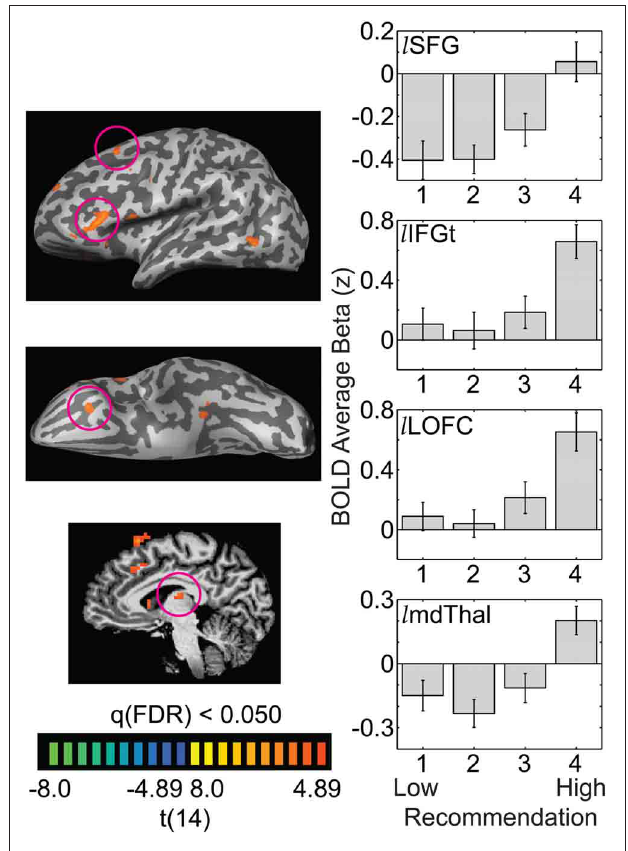
FIGURE 5 | Anterior frontal regions and an associated region of the thalamus show non-linear, “step-like” responses to increasing recommendation. The whole-brain images illustrate the t -statistic for the 4-vs.-1 contrast. Panels on the right illustrate the average beta weight (as a z -score) for each recommendation level, averaged across 15 observers ( l SFG = left superior frontal gyrus; l IFGt = left inferior frontal gyrus, pars triangularis; l LOFC = left lateral orbitofrontal cortex; l mdThal = left mediodorsal thalamus). Error bars are standard errors of the mean across